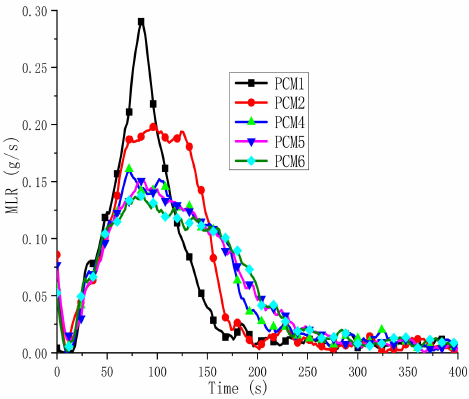
Figure 12. Mass loss rate (MLR) curves of the